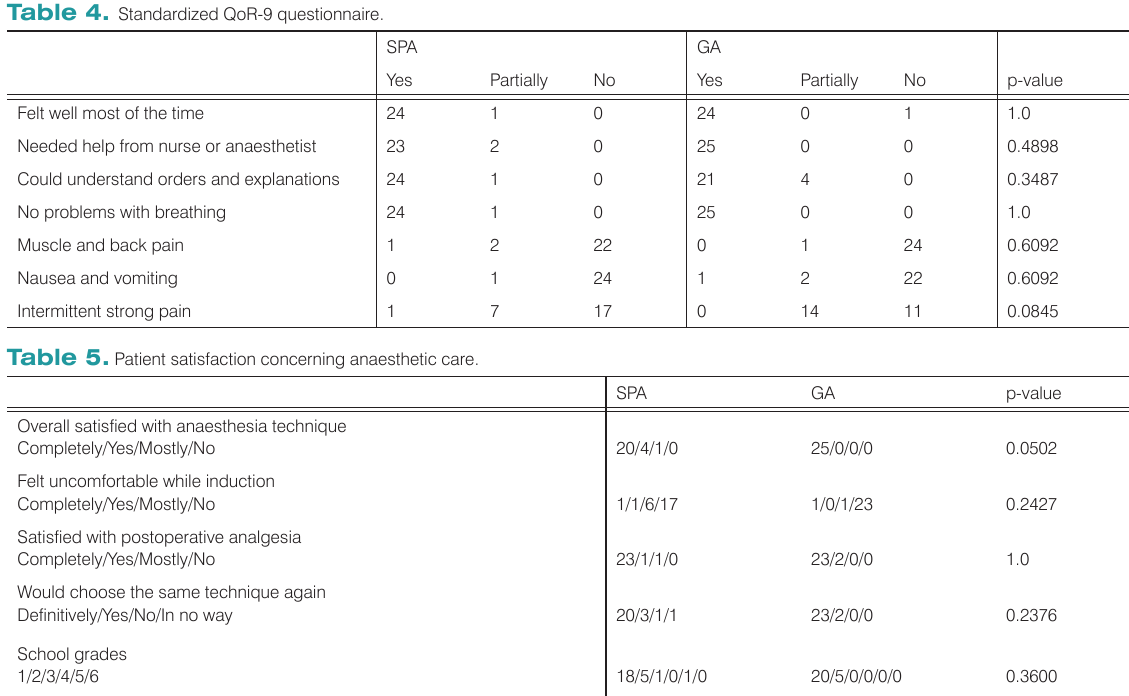
Table 4. Standardized QoR-9 questionnaire.